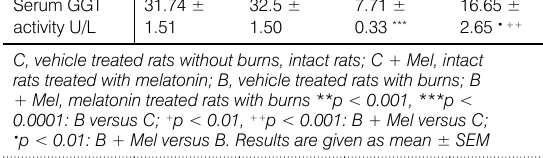
Table 1. Hepatic MDA and serum GGT activity after burns in rats Parameter/ C C + Mel Group